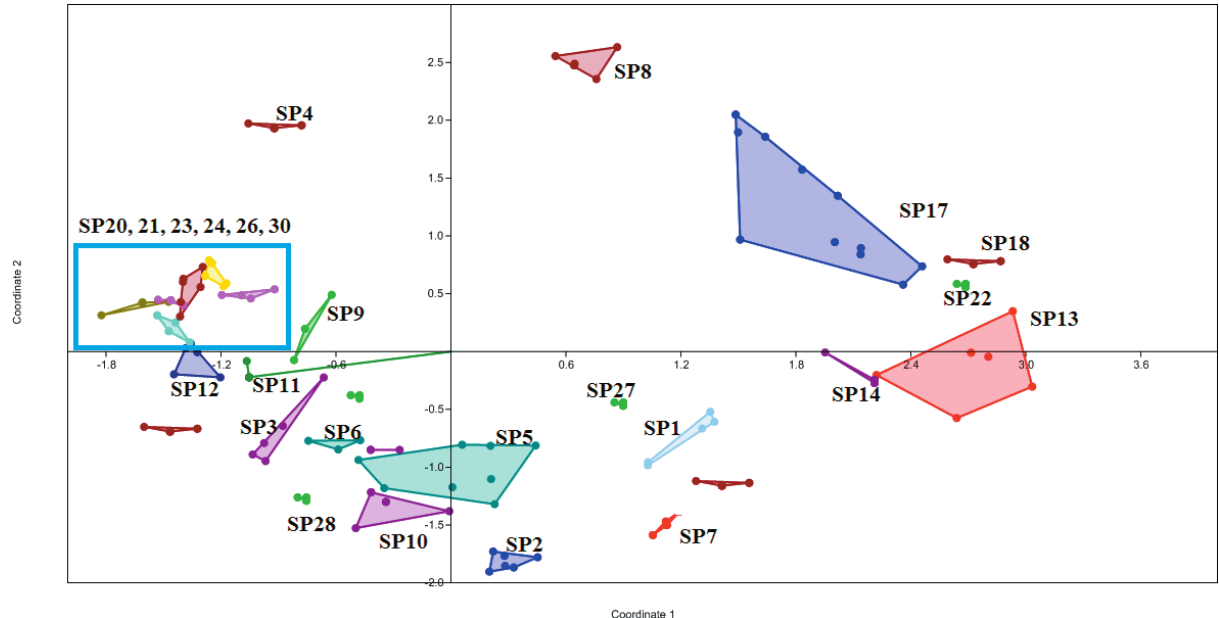
Figure 2. PCoA plots of morphological characters revealing species delimitation in the Salvia. sp1= Salvia aristata; sp2= S. eremophila; sp3= S. santolinifolia ; sp4= S. tebesana; sp5= S. bracteata ; sp 6= S. suffruticosa ; sp7= S. dracocephaloides ; sp8= S. hydrangea; sp9= S. multicaulis ; sp10: S. syriaca ; sp11: S. viridis; sp12= S. mirzayanii ; sp13= S. macrosiphon; sp14= S. sharifii; sp15= S. reuterana; sp16= S. palaestina; sp17= S. sclareopsis; sp18= S. spinose; sp19= S. compressa; sp20= S. sclarea; sp21= S. aethiopis; sp22= S. microstegia; sp23= S. xanthocheila; sp24= S. limbata ; sp25= S. chloroleuca ; sp26= S. virgate; sp27= S. nemorosa; sp28= S. urmiensis ; sp29= S. oligphylla; sp30= S. verticillata.